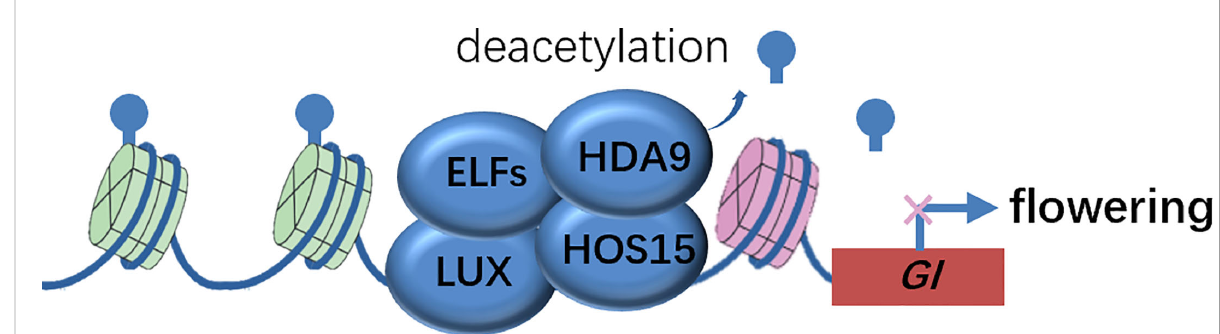
FIGURE 2 Molecular model of HOS15-mediated higher-order repressive complex in GI promoter region to inhibit GI expression via histone deacetylation. Inhibition of GI expression delays fl owering time. EFLS, EARLY FLOWERINGS; GI, GIGANTEA; HDA9, HISTONE DEACETYLASE 9; HOS15, HIGH EXPRESSION OF OSMOTICALLY RESPONSIVE GENE 15; LUX, LUX